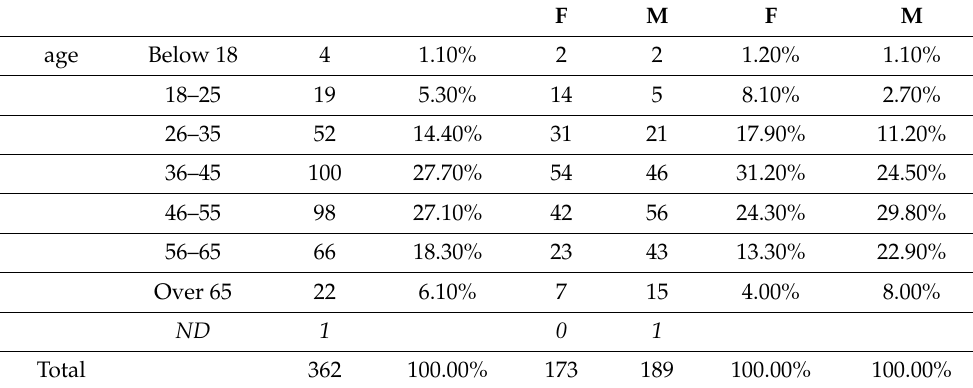
Table 2. Age of the